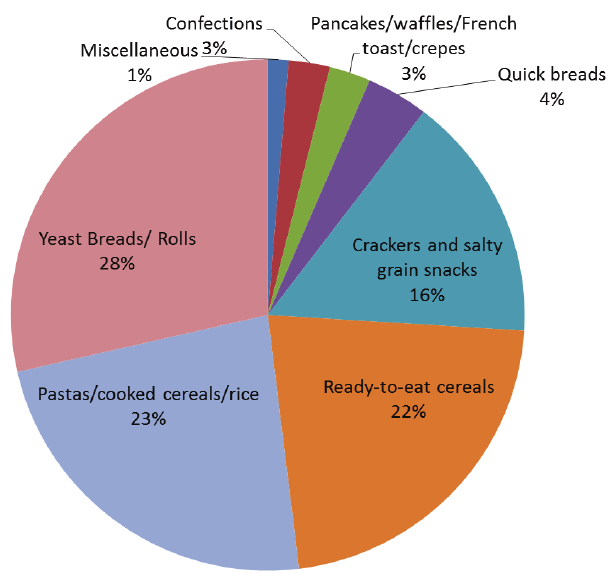
Figure 2. Products that contributed to adult whole grain intake. Data represent the average consumption of different categories of whole grain foods from the National Health and Nutrition Examination Survey (NHANES) 2009 – 2010